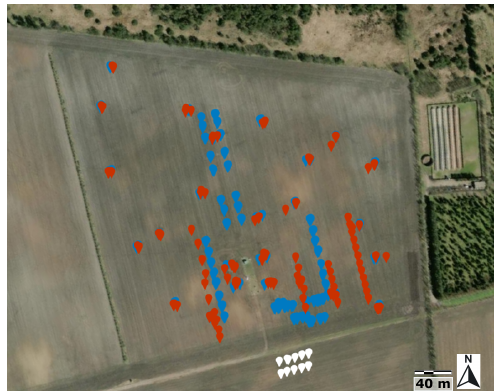
Figure 4. The spatial distribution of the AGB sampling locations. Each color indicates one of the original datasets: red represents the barley samples that were collected in 2020 (i.e., barley 20 ); blue represents the wheat samples that were collected in 2021 (i.e., wheat 21 ); white represents the barley samples that were collected in 2021 (i.e., barley 21